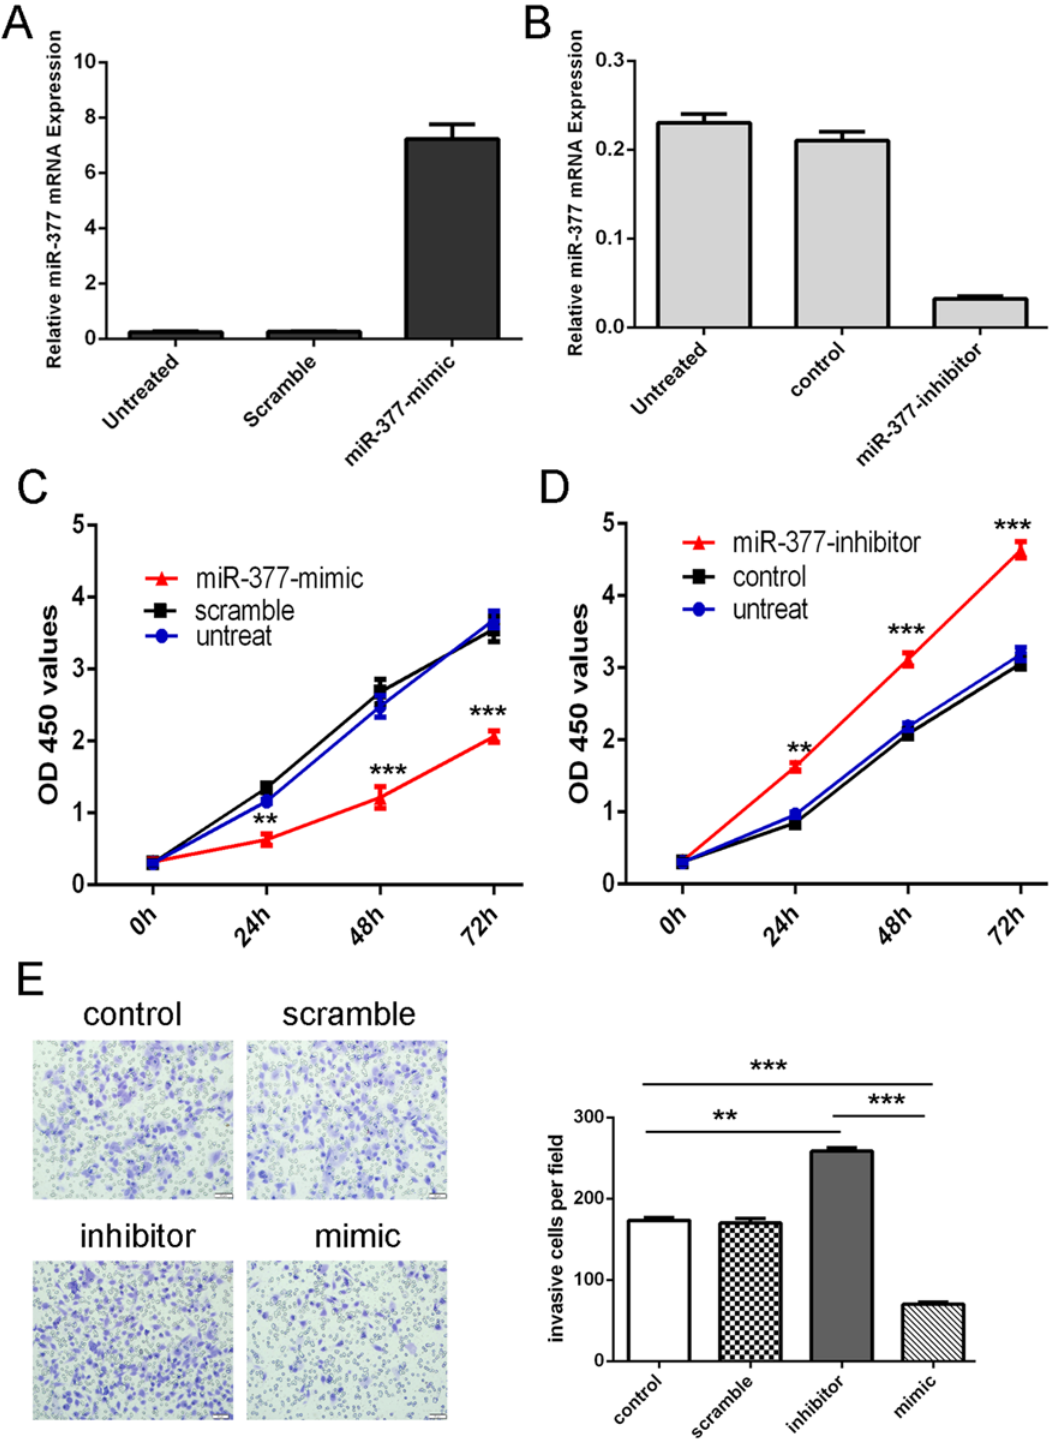
Fig 3. MiR-377 inhibits HCC cell proliferation and invasion. (A) Real-time RT-PCR analysis of miR-377 in HepG2 cells upon transfection of miR-377. The expression of miR-377 in HepG2 cells transfected with miR-377 mimics was up-regulated. U6 snRNA was used as internal control. (B) The expression of miR-377 in HepG2 cells transfected with miR-377 inhibitor was down-regulated. U6 snRNA was used as internal control. (C) Invasion analysis of HepG2 cells after treatment with miR-377 mimics, inhibitors or scramble or control; the relative ratio of invasive cells per field is shown below, * p < 0.05, ** p < 0.01, and *** p <